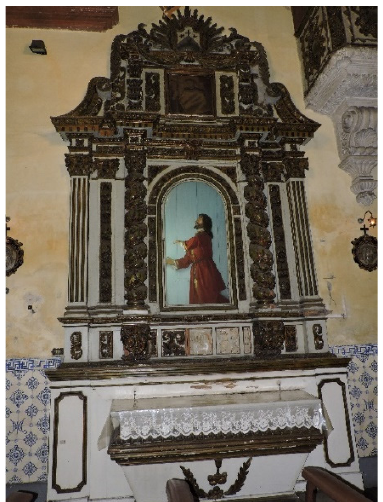
Figure 11. Agony in the Garden , in the Church of the Third Order of Mount Carmel in Santos. Poly- chrome wood sculpture (96 × 50 × 40cm), eighteenth century. Photo by Lia Brusadin, 29 December 2016.